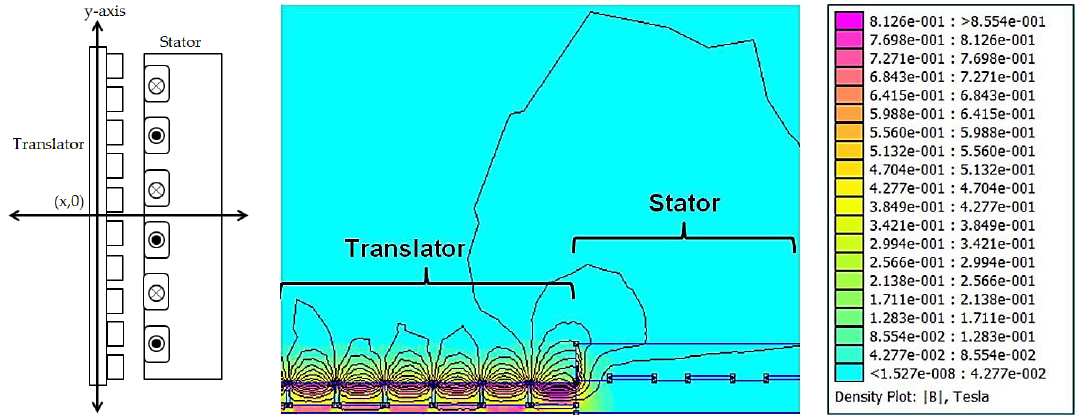
Figure 20. Optimum position ( left ) and flux density (B) in the non-facing event ( right ).